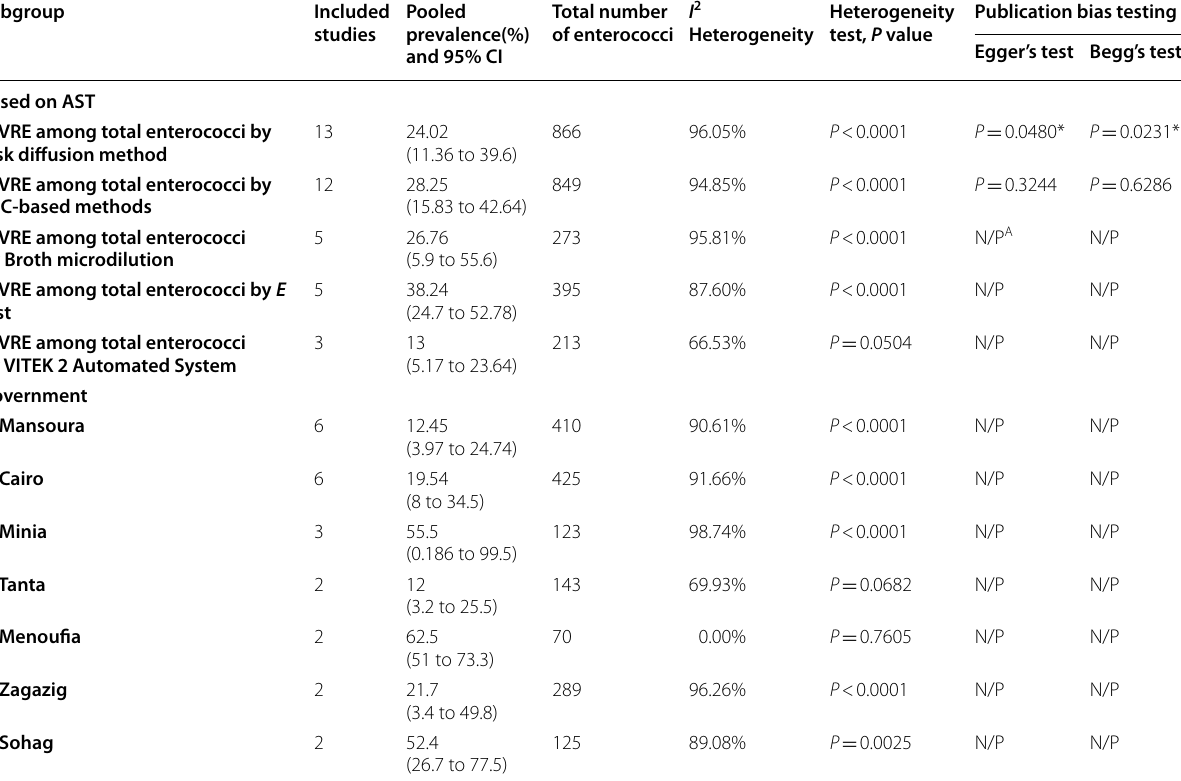
Table 1 Pooled prevalence of VRE in Egypt by subgroups